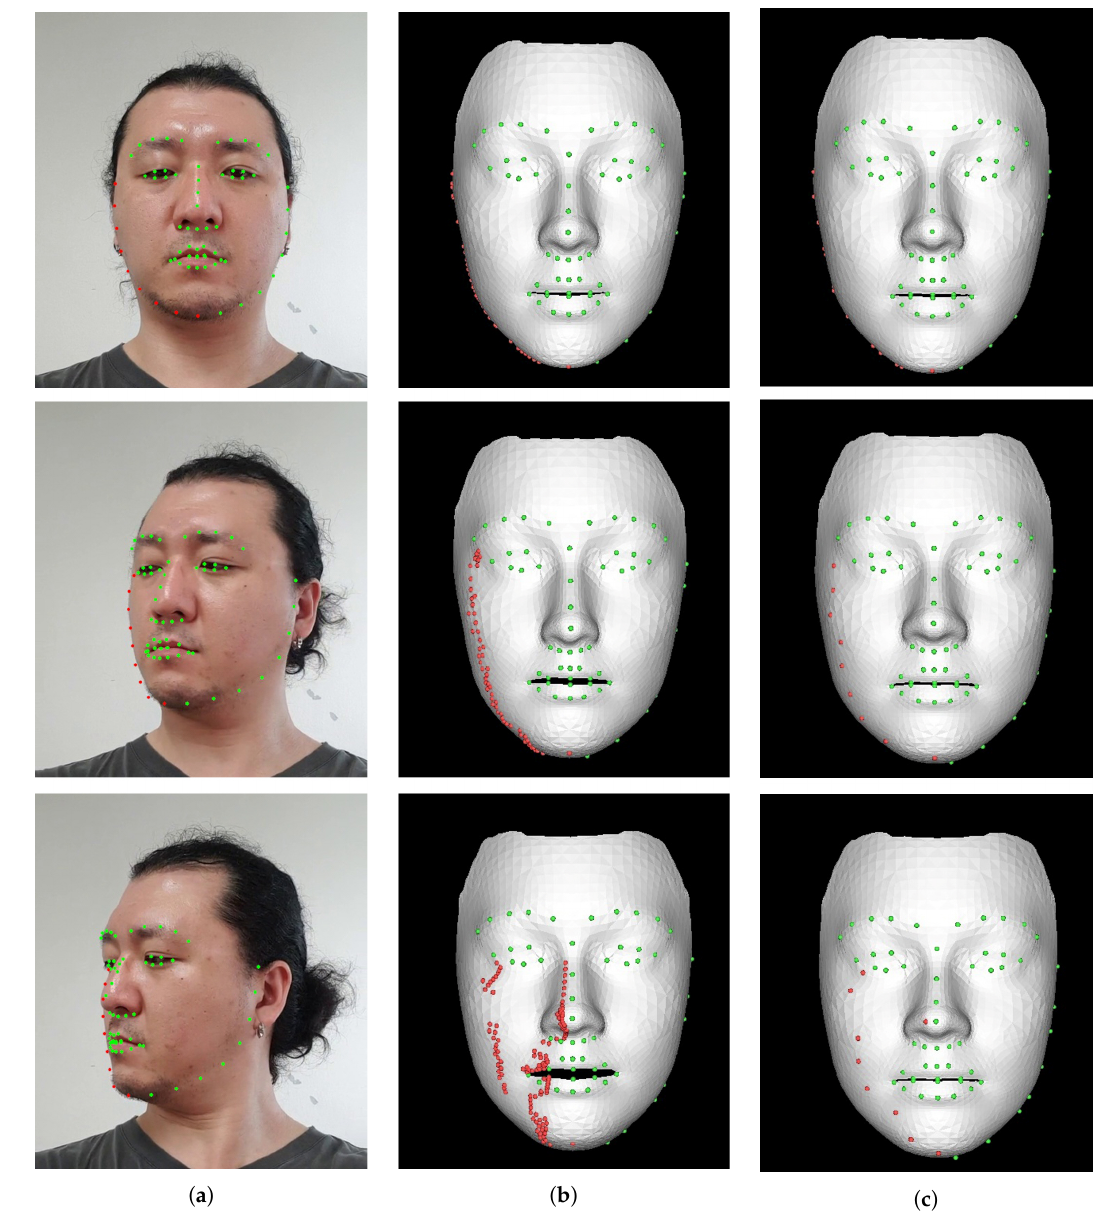
Figure 3. Results of face model fitting: ( a ) face landmarks detected from the video frame; ( b ) corresponding landmarks on the model searched by Huber et al. [21]; and ( c ) corresponding landmarks on the model searched by the proposed framework. Green dots indicate facial landmarks, and red dots highlight facial outline